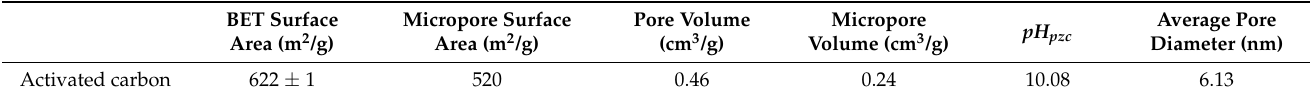
Table 1. Commercial activated carbon